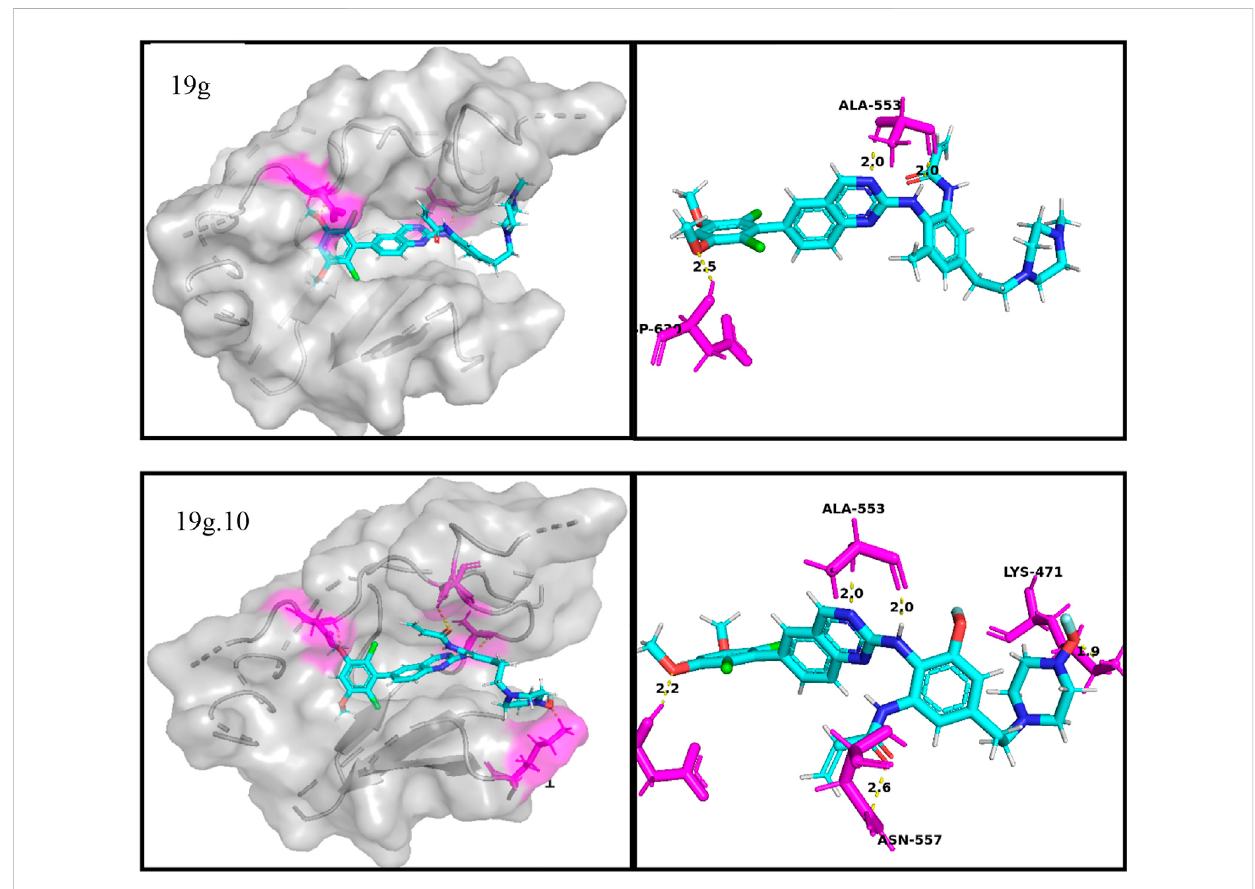
FIGURE 8 Docking assay of compounds 19g, and 19g.10 with osteosarcoma related target (FGFR4, PDB ID: